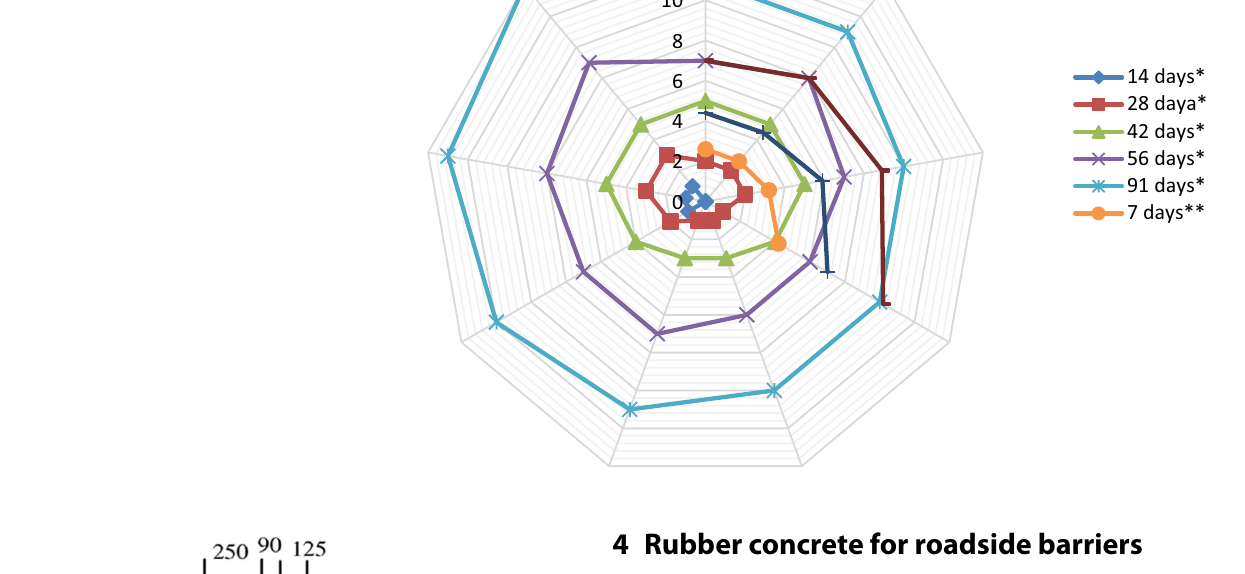
Fig. 23 Carbonation depth (mm) with respect to rubber %